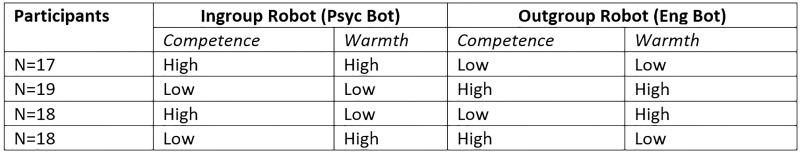
Participant group allocation for Experiment 2.